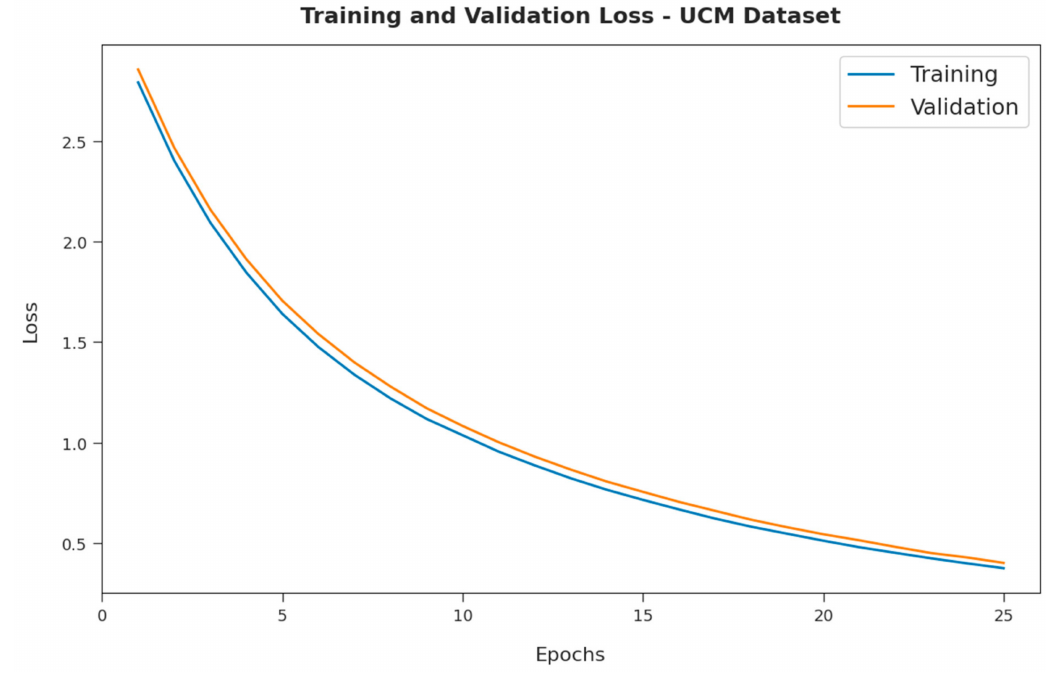
Figure 7. TL and VL analysis of SIDTLD-AIC technique on UCM dataset.